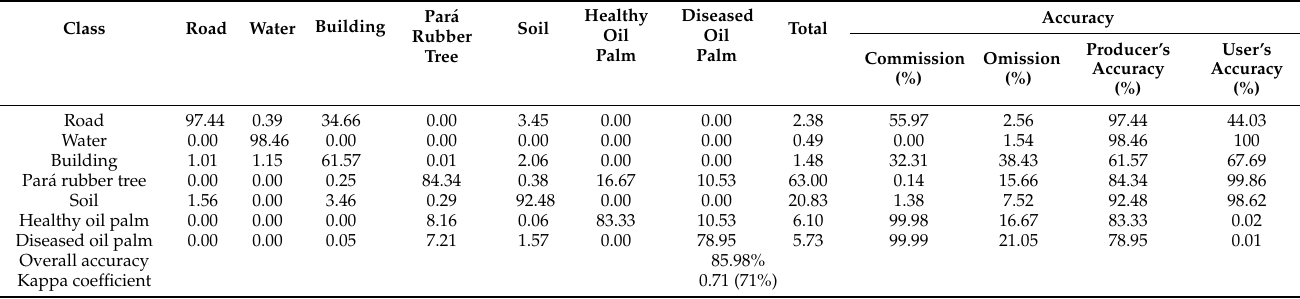
Figure 9. Statistical distribution of the vegetation indices values of the pixels encompassing the palm oil trees sampled. All 113 samples from Areas 1 and 2 were taken into account cumulatively for each case. Boxes encompass the 25% and 75% quartiles of each dataset, the bars represent the 95% confidence intervals, the central solid line represents the median, and the dots represent outliers. Table 3. Error matrix of the maximum likelihood classification. Percentage comparing results of data mixing in each data type by pixel based classification